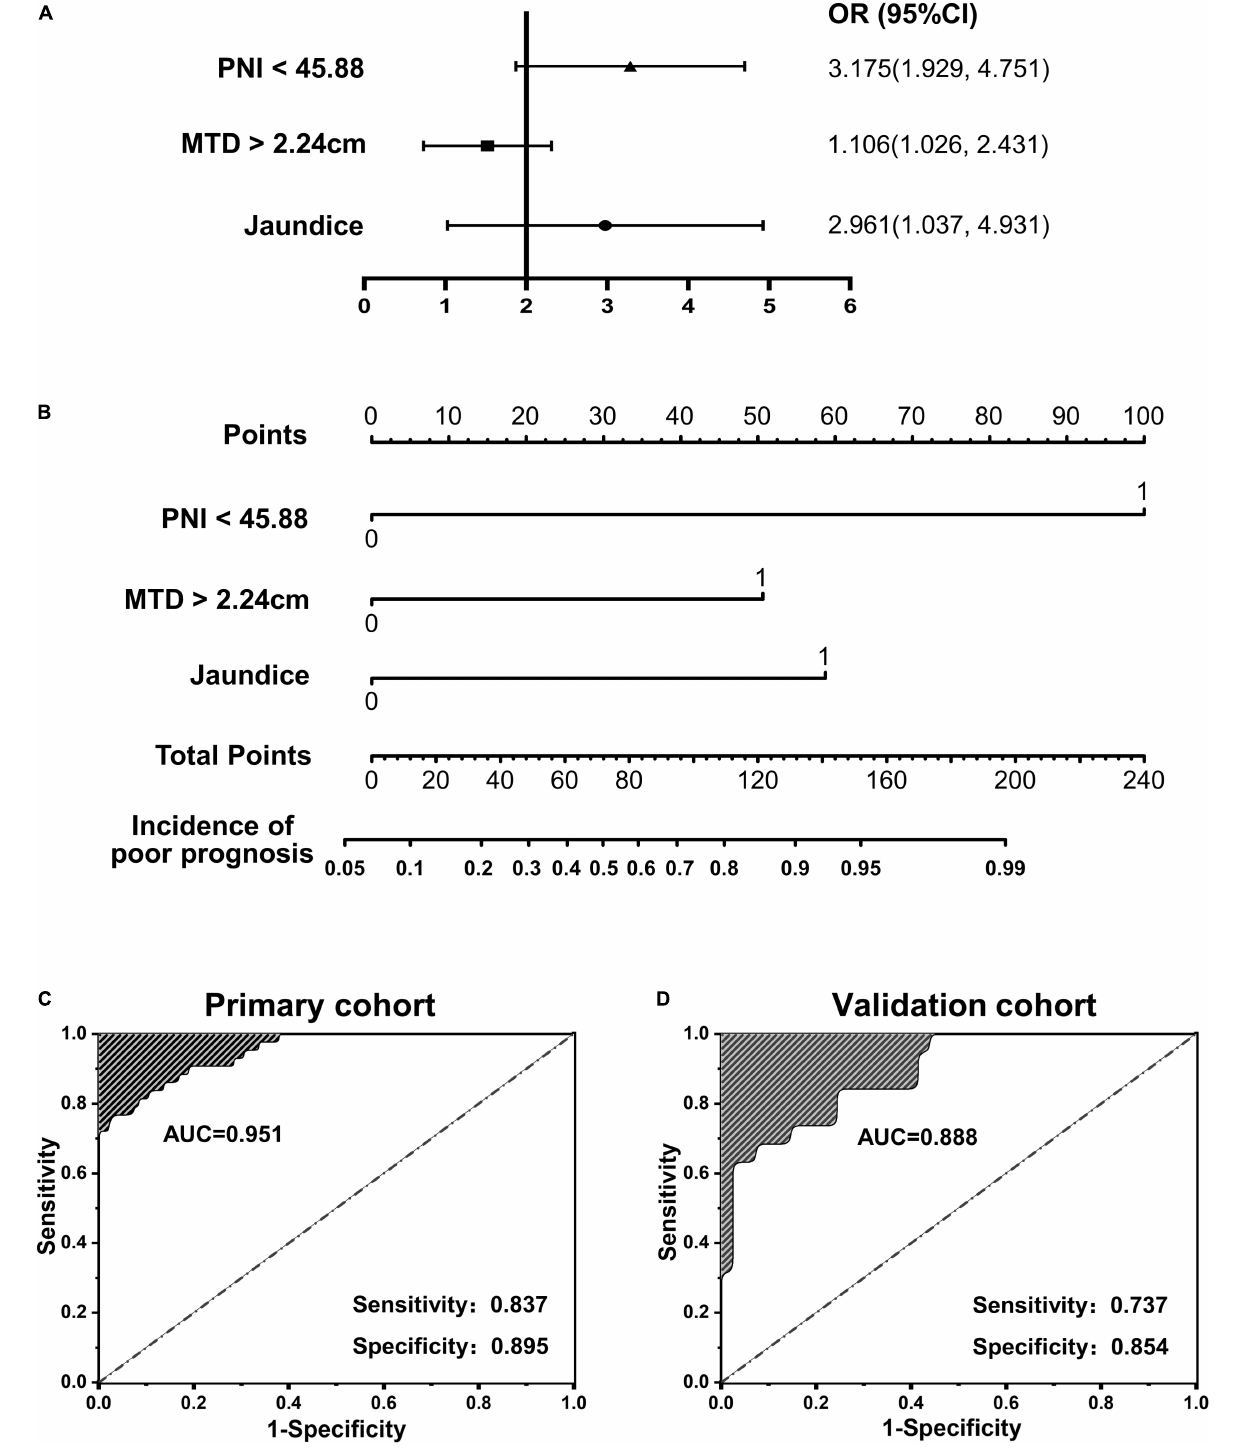
FIGURE 2 | (A,B) Forest plot and nomogram plot of independent predictors of poor prognosis with odds-ratio ( OR ) multivariate regression model; (C,D) area under the curve (AUC) in the primary cohort and validation cohort.